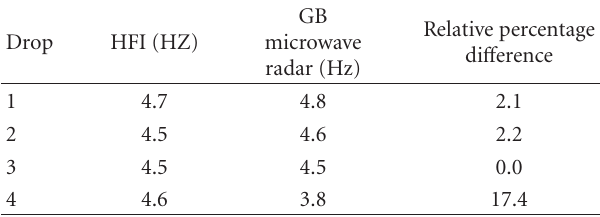
Table 5: Comparison between the oscillation frequencies measured by HFI and GB microwave Radar with the relative percentage di ff